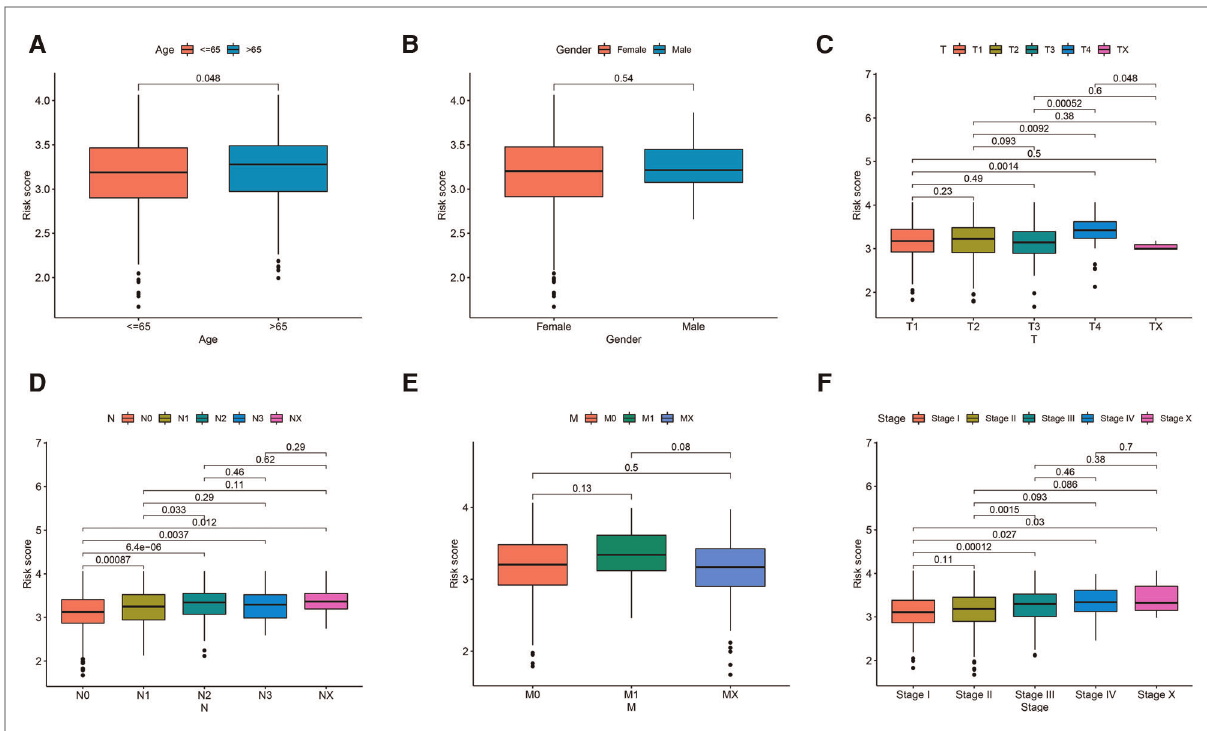
FIGURE 5 Relationship of risk score and clinicopathological features, including ( A ) age, ( B ) gender, ( C ) AJCC-T, ( D ) AJCC-N, ( E ) AJCC-M and ( F )